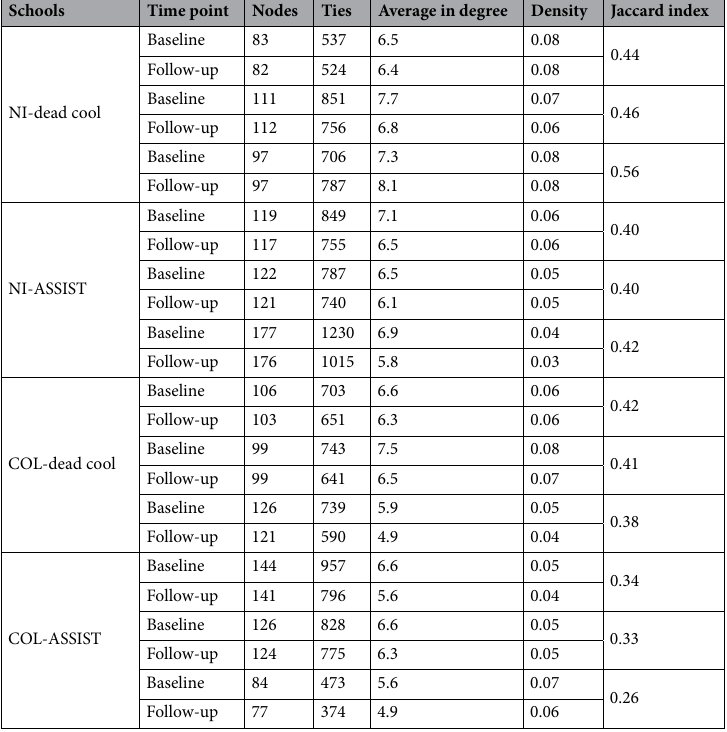
Table 3. Friendship networks measures. Nodes represent individual participants; Ties represent the friendship nomination between participants; average in degree represents the mean number of friends nominated per individual participant; density is the ratio of the number of ties observed to the number of possible ties for a given network. Jaccard Index measures the structural change between follow-up and baseline, thus there is only one coefficient per school over